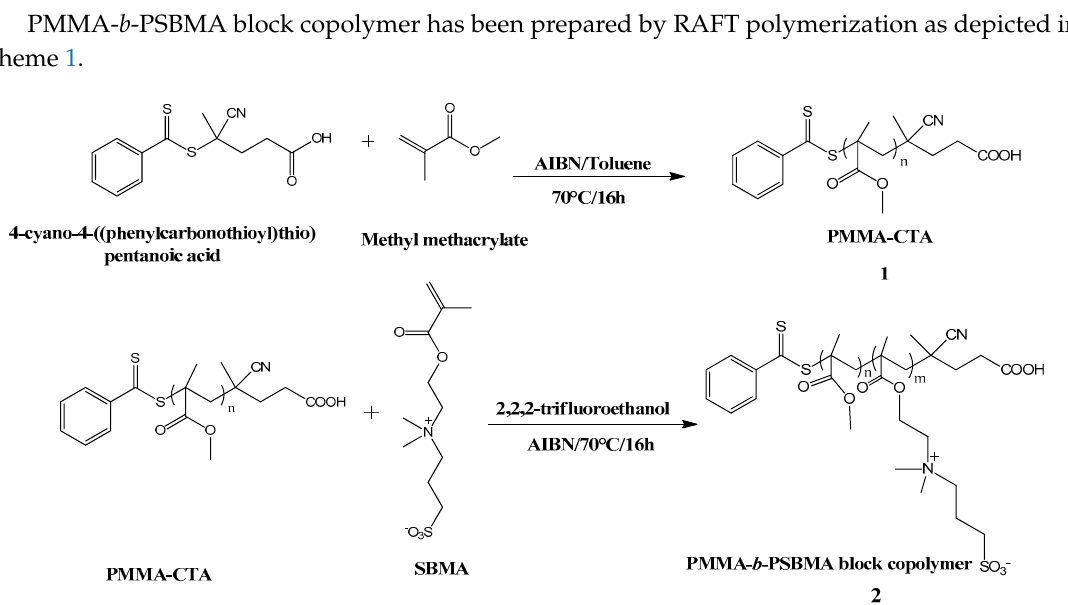
Scheme 1. RAFT polymerization of PMMA- b -PSBMA block